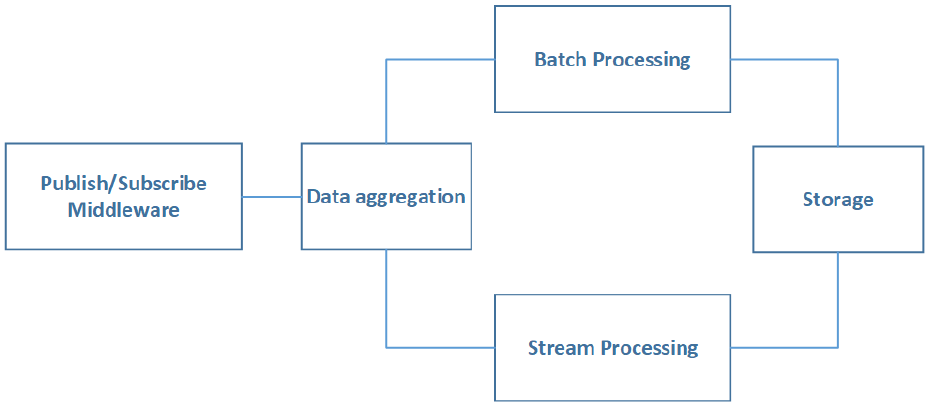
Figure 12. Topology view of Lambda based